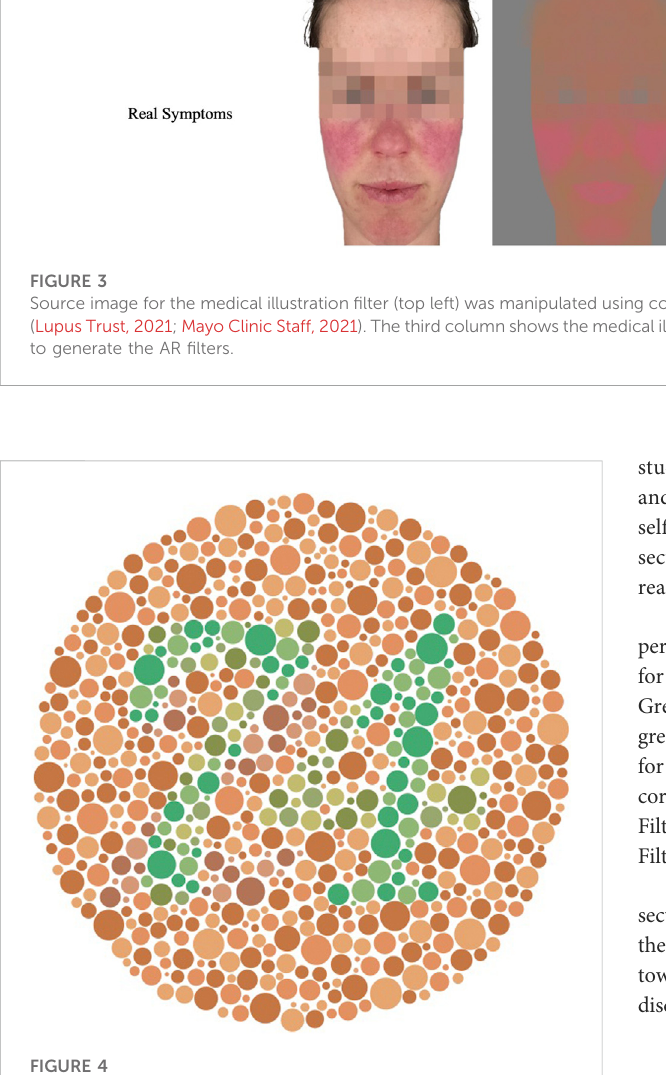
malar rash. For Section 3.2 and Section 3.3, the units of measurement refer to the alpha level of the fi lter when students fi rst noticed changes and noticed the malar rash pattern, respectively. A lower score for these sections is interpreted as